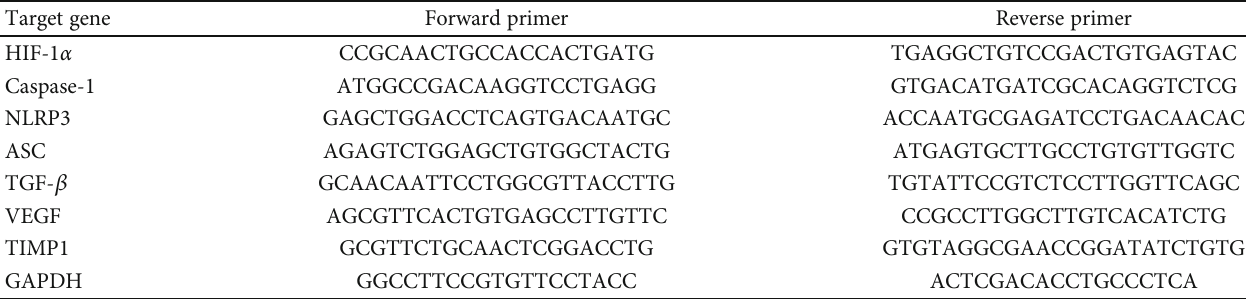
Table 1: Nucleotide sequences of primers used for RT-PCR ampli fi